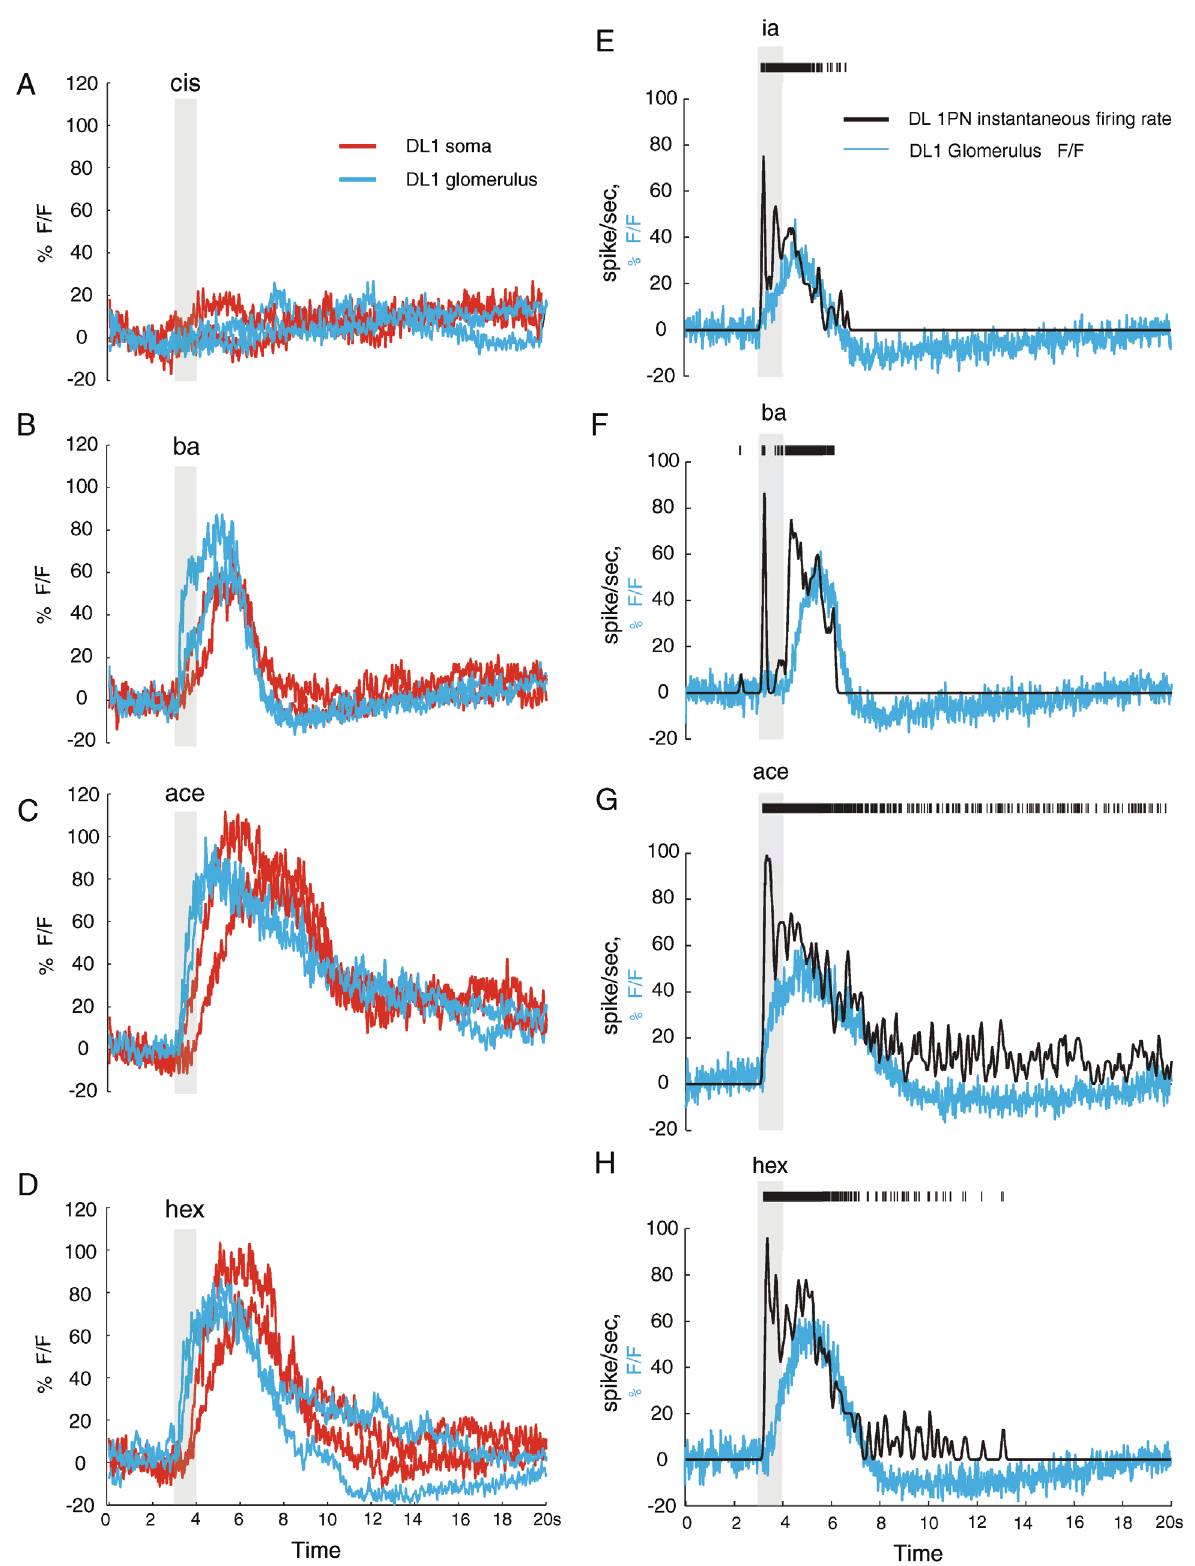
Figure 4. G-CaMP signal can be dependent on location imaged . ( A–D ) Glomerular G-CaMP signal versus somatic G-CaMP signal for the same DL1PN (NP3529-Gal4, UAS-GCaMP fly) shows different kinetics. Shown are two trials each of somatic and glomerular line scans (order: soma-glomerulus-soma- glomerulus, all odors tested at each step). Glomerular signal precedes somatic signal by 400 ± 226ms as measured by odor response signal exceeding 2.5SDs of baseline. ( E–H ) Comparison of instantaneous firing rate based on somatic electrical recordings and glomerular delta F/F. Although the G-CaMP signals show improved kinetics, they do not accurately capture the dynamics of the response, failing to correctly capture short bursts of intense electrical activity as high as 80Hz. Mean correlation between G-CaMP signal and instantaneous firing rate for these experiments = 0.71 ±